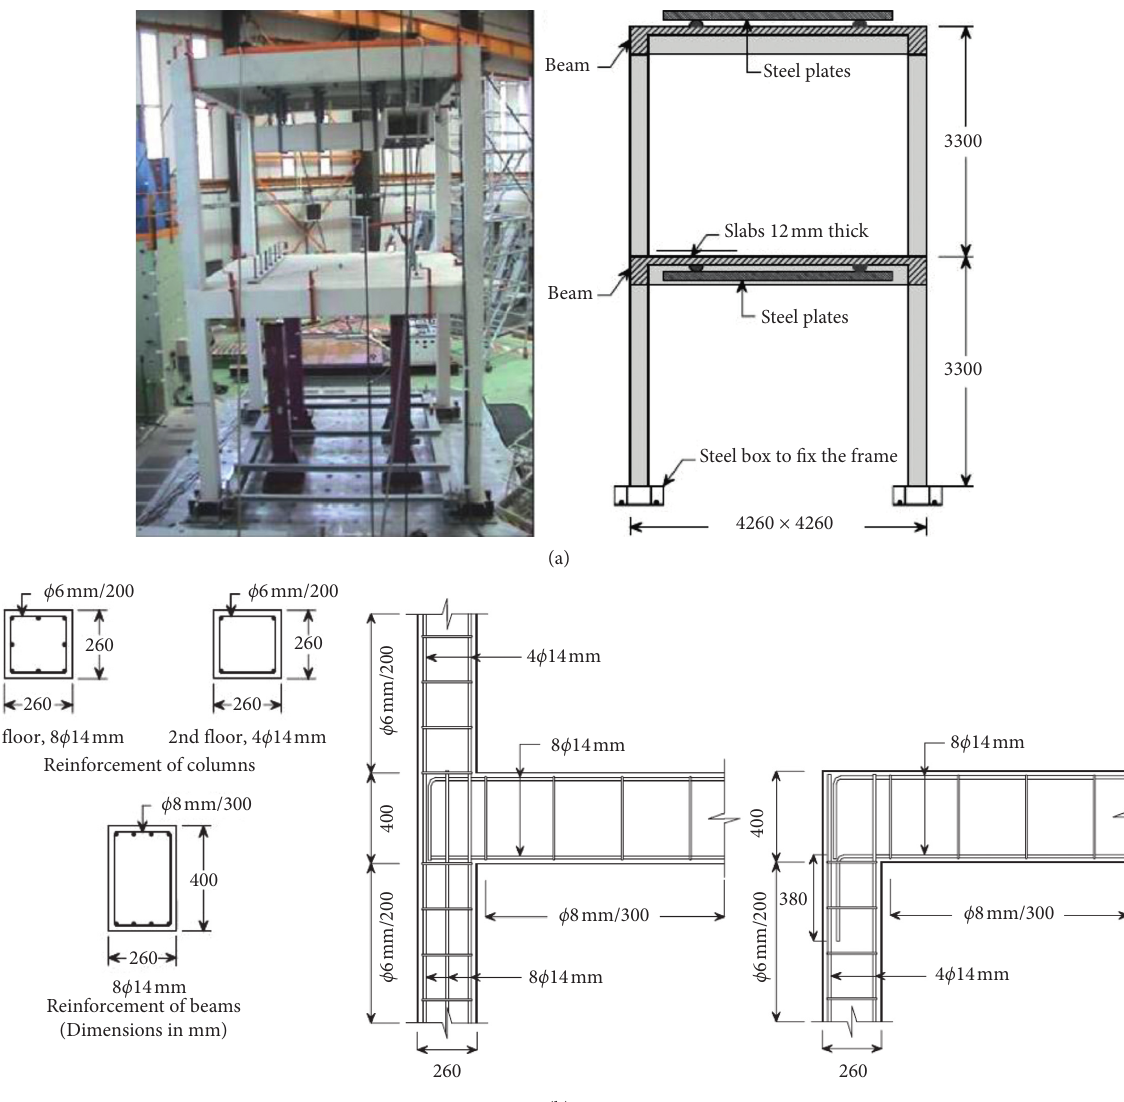
Figure 4: The tested two-storey RC frame [20, 95]. (a) General view. (b) Cross-sections and reinforcement details of columns and